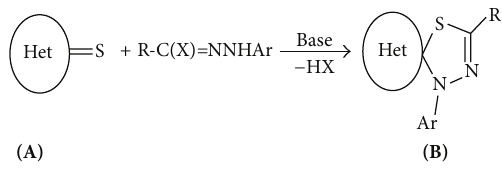
Figure 3: Synthesis of